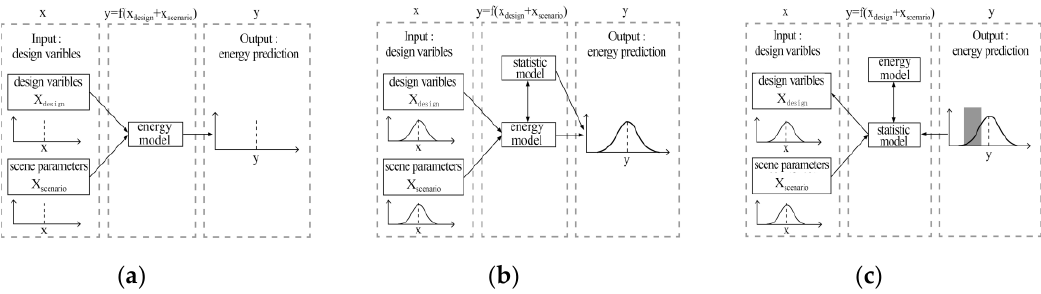
Figure 2. Deterministic forward simulation ( a ), probabilistic forward modeling ( b ), probabilistic reverse simulation workflow ( c ).